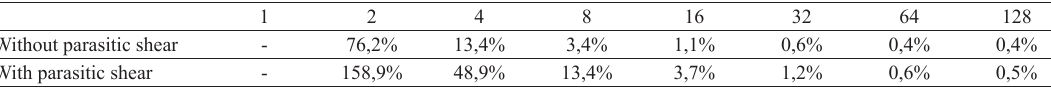
With parasitic shear Table 9. Natural frequencies (nondimensional values) for CS beam - Laminated composite with (0/90/90/0) lamination scheme. Model corrected for parasitic shear. Element Present solution: mode number